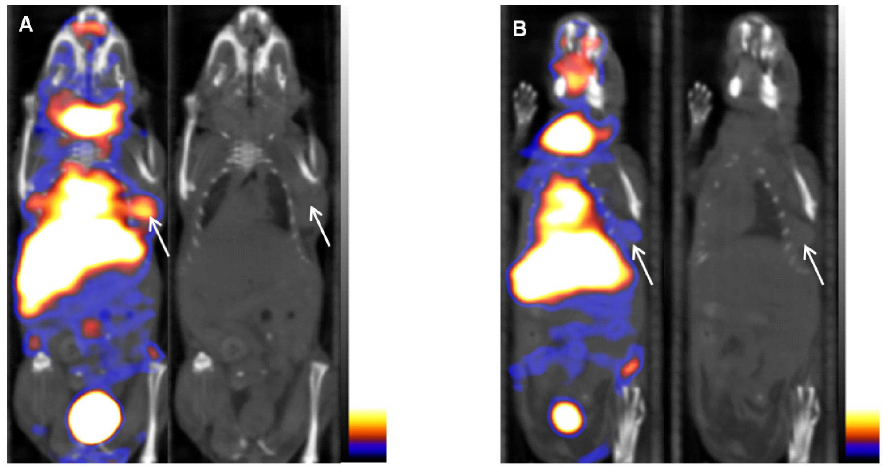
Figure 5. Imaging of the nude mouse model of insulinoma 90 min after blocking with liraglutide. Small-animal SPECT/CT imaging indicated that tumour images significantly faded after blocking with liraglutide ( B ), while A presents an image obtained prior to blocking. The images of the lungs also faded after blocking. The coronal CT images correspond to the SPECT/CT images, and the arrow indicates the tumour location.